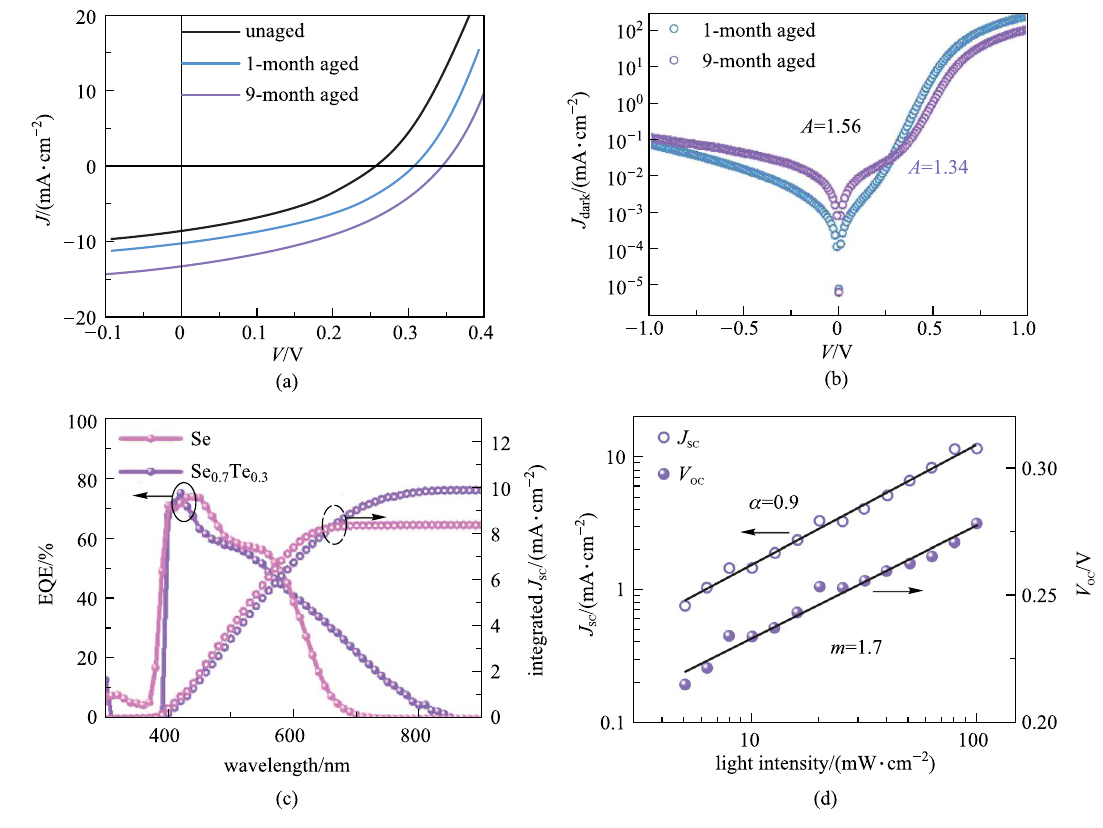
Fig. 3 a J – V curves of ZnO/Se 0.7 Te 0.3 solar cells for different aging time under AM 1.5G solar illumination. b Dark Se